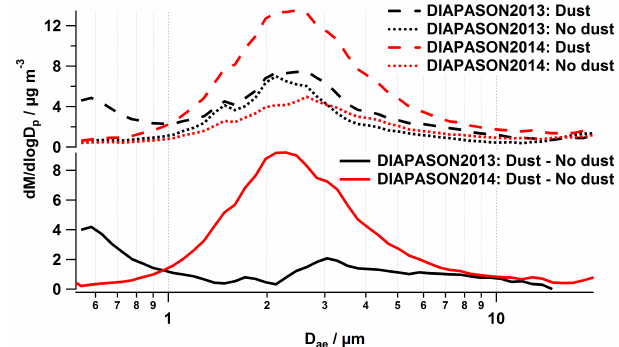
Figure 3. Size-resolved mass distribution (d M /dlog D p ) during dust (dashed traces) and no dust (dotted traces) periods (top panel) mea- sured with the APS during DIAPASON2013 (black traces) and DI- APASON2014 (red traces). The difference of the size-resolved mass distributions measured during dust and no dust periods indicate the size distributions of the dust particles measured during both years (bottom panel). D ae is the aerodynamic particle